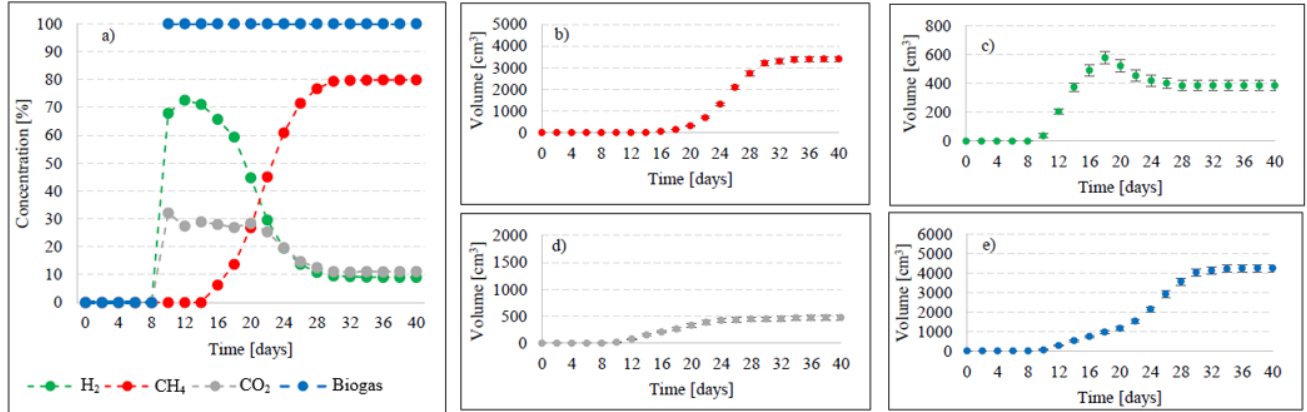
Figure 5. Changes in concentrations of biogas fractions in V3 ( a ); total volumes of CH 4 ( b ), H 2 ( c ), CO 2 ( d ), and biogas ( e ).